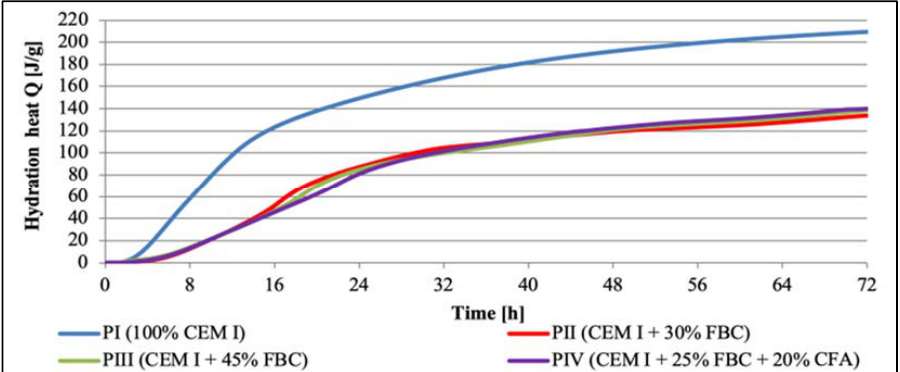
Figure 5. Particle-size distribution of cement–fly-ash binders.